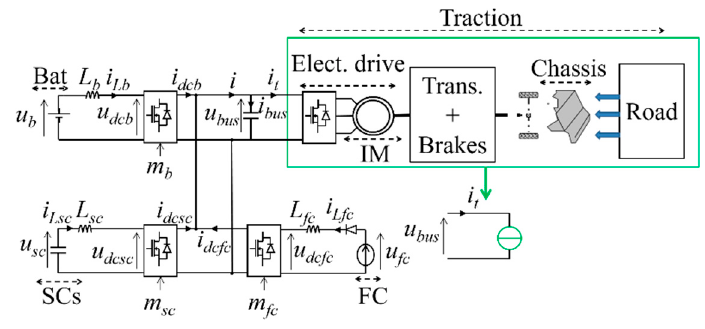
Figure 1. System architecture.